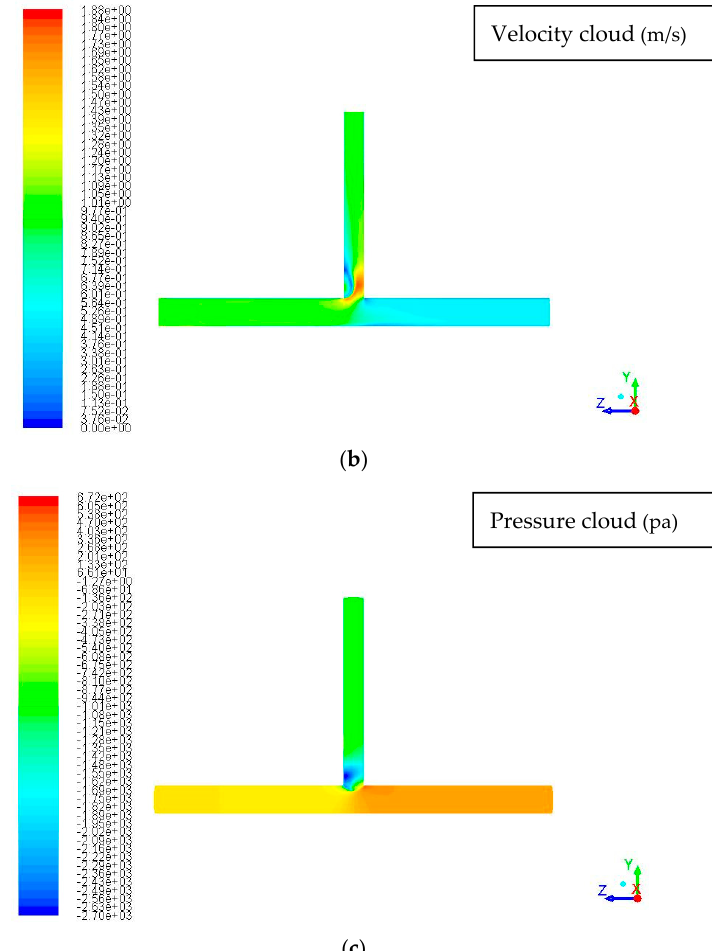
Figure 16. Numerical simulation results for the tee outlet pipe diameter 110 mm, flow rate 0.1 m/s; ( a ) Wall shear stress cloud; ( b ) Velocity cloud; ( c ) Pressure